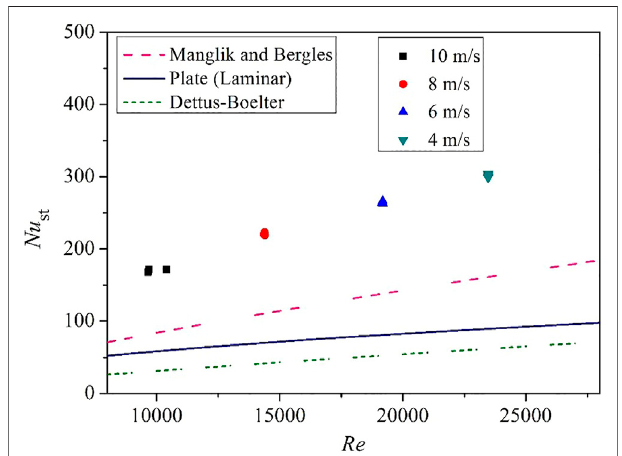
FIGURE8| Comparisonofexperimentaldatawithpublishedcorrelations.